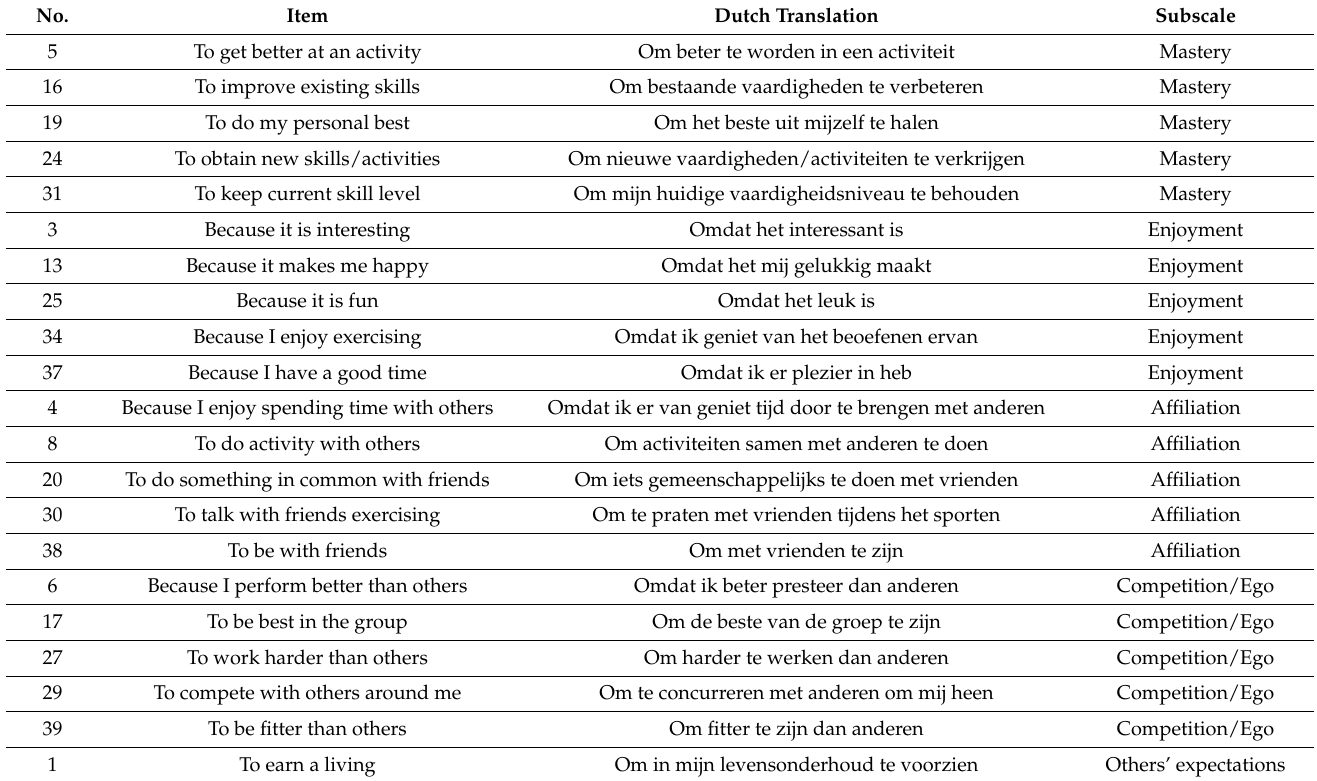
Table A1. Items and subscales of the PALMS-Dutch